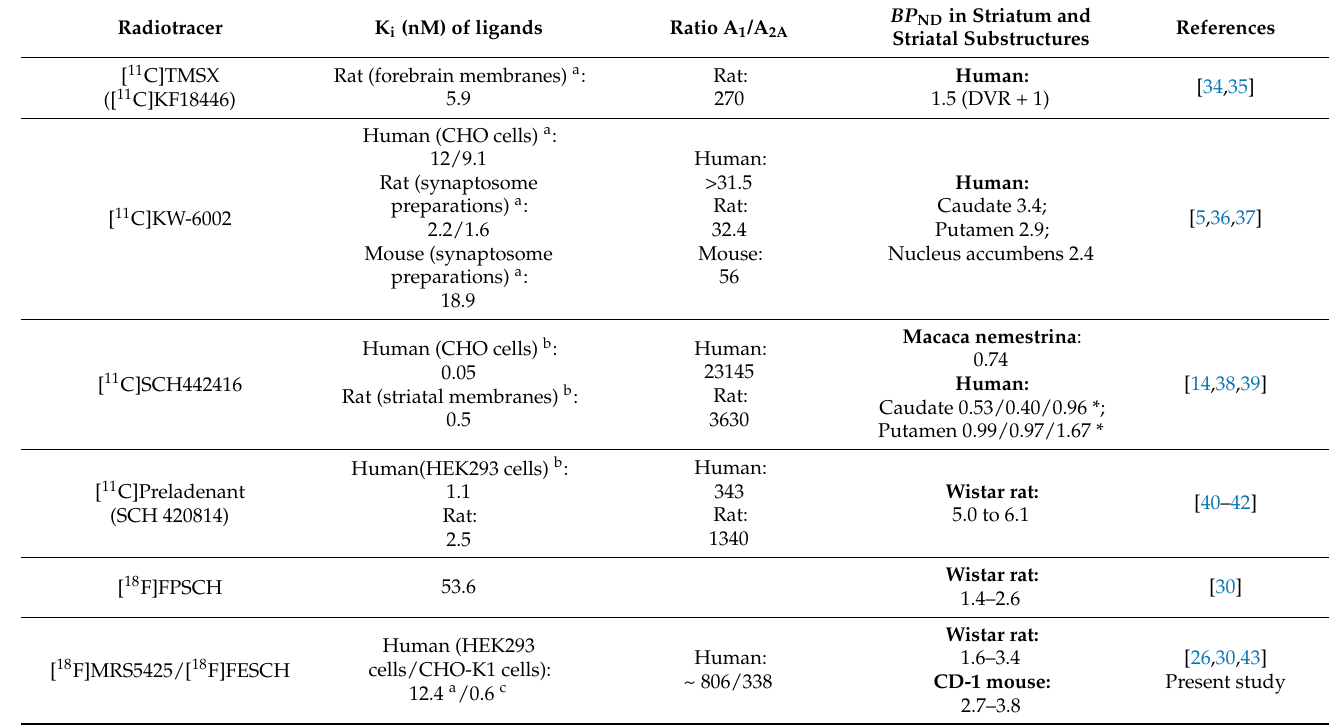
Table 8. A 2A R receptor affinity ( K i ), selectivity, and the striatal binding potential ( BP ND ) derived by SRTM (or as stated) of different A 2A AR-targeting PET radiotracers of different